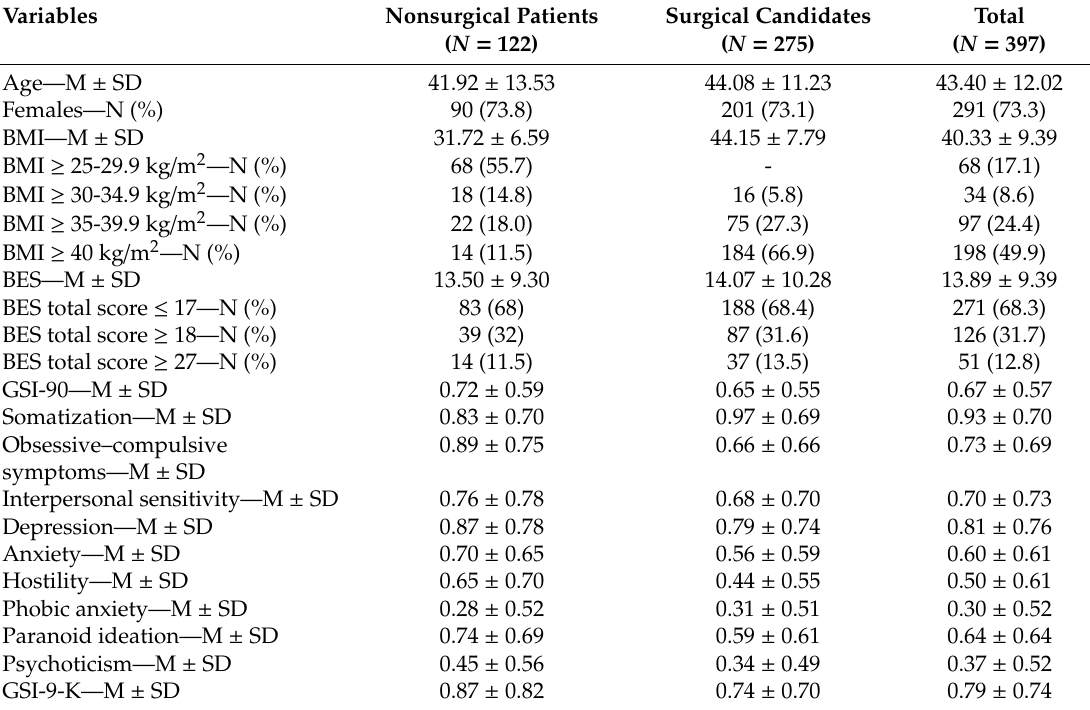
Table 1. Descriptive statistics of the